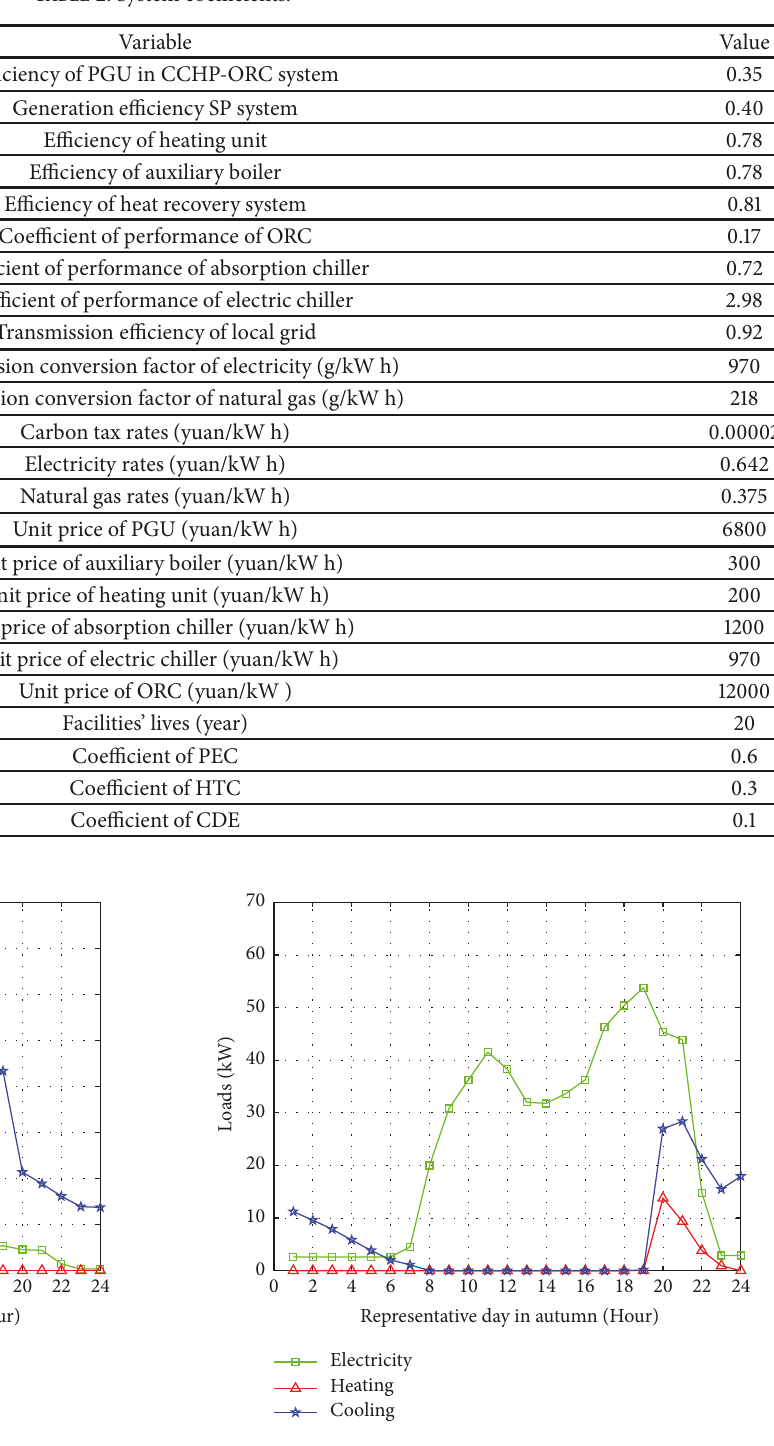
Figure 4: Hourly energy requirements in a summer day. Figure 5: Hourly energy requirements in a autumn day.